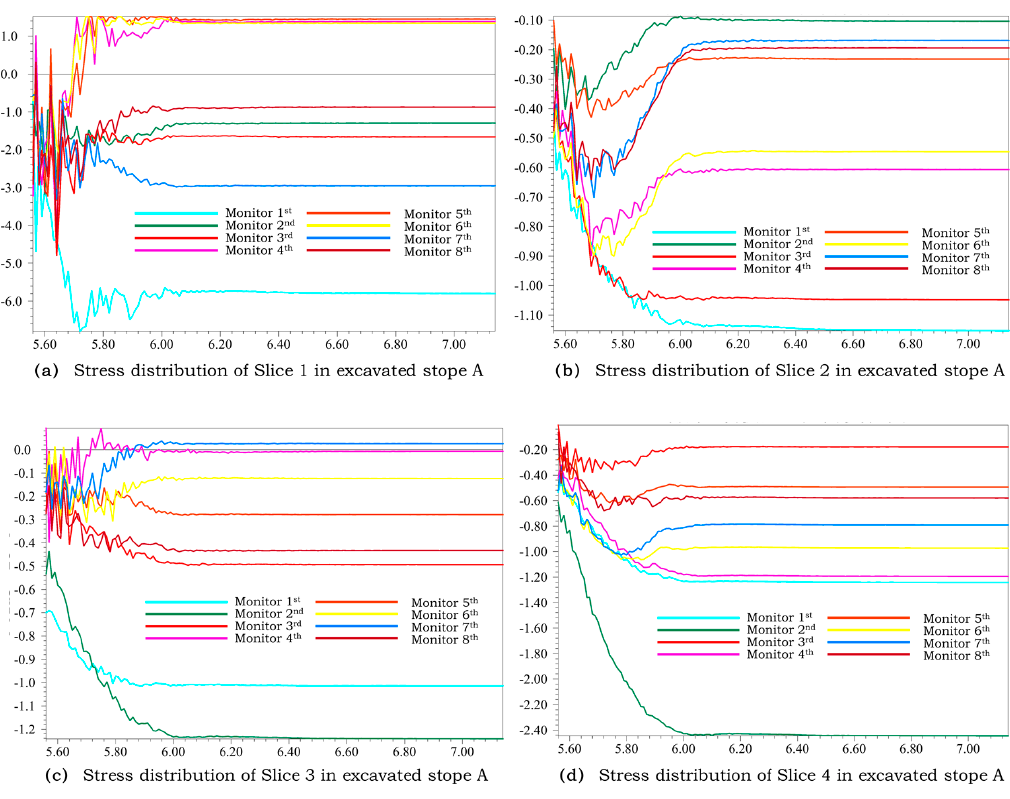
Figure 7. Stress distribution features in Slices 1 to 4 for excavated Stope A.